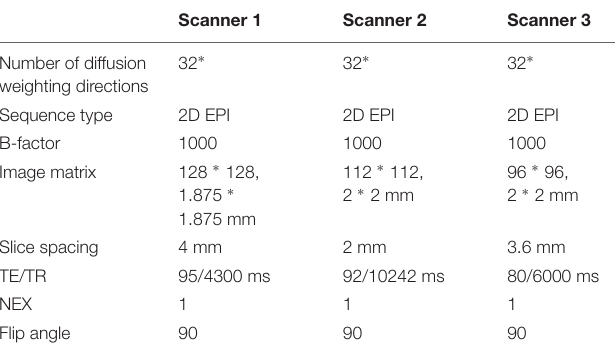
TABLE 1 | Diffusion tensor imaging acquisition parameters used in the